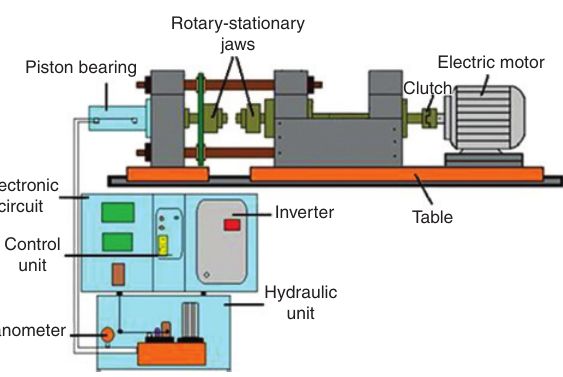
Figure 3 Macrograph of the welded composite samples. Table 2 Chemical composition of B